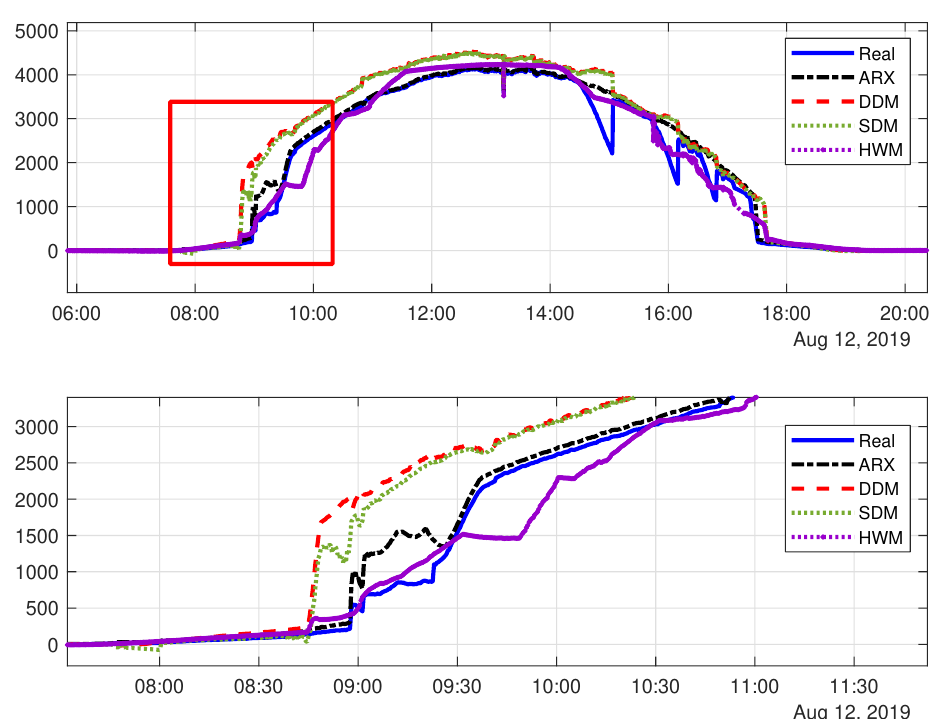
Figure 11. General comparison (top) between real output system and Single-Diode Model,